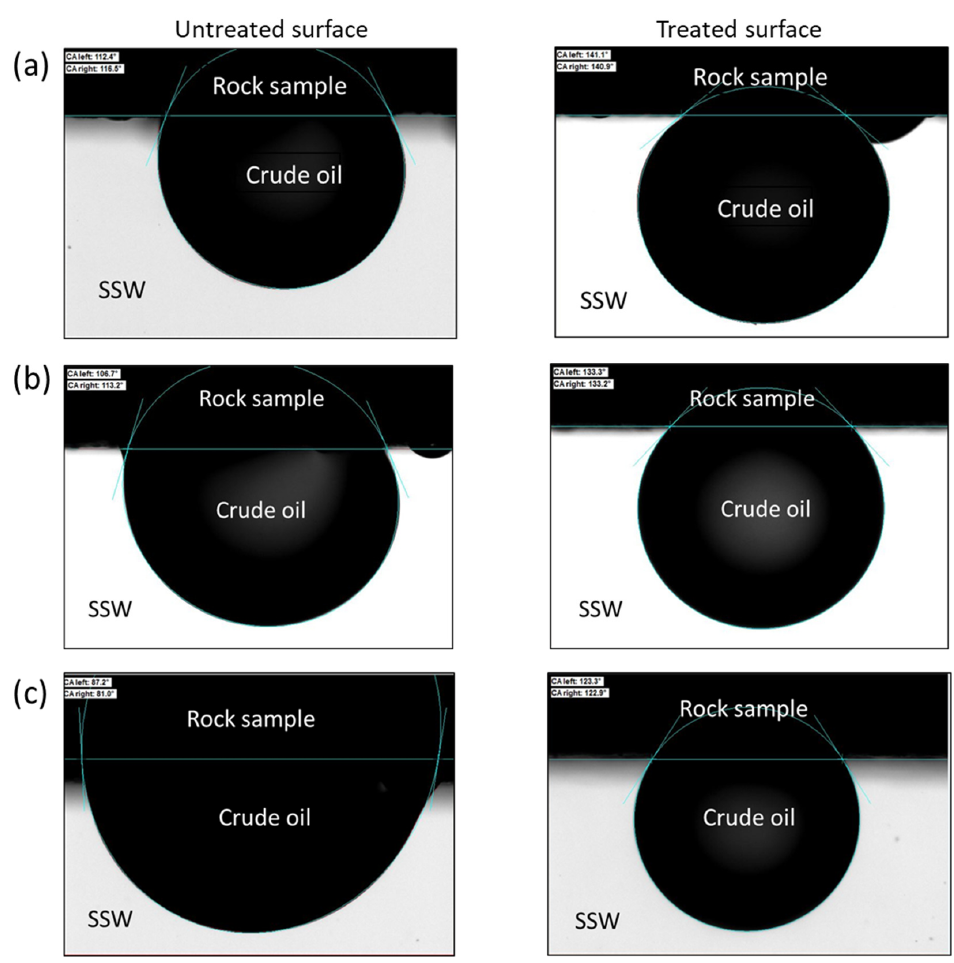
Figure 10. Contact angle measurements on untreated and nanofluid (1 wt.% OF50-M) treated surfaces of ( a ) Bentheimer Sandstone, ( b ) Berea Sandstone, and ( c ) Austin Chalk rock samples at room temperature. Table 4. Contact angles measured on untreated and treated rock surfaces.